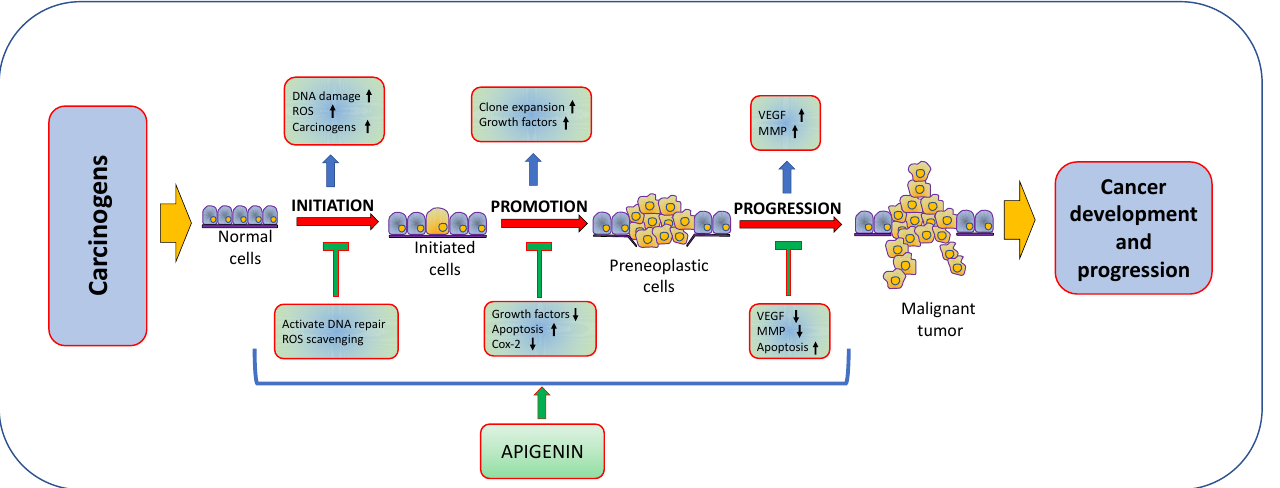
Figure 3. Anti-cancer activity of apigenin: Apigenin plays a significant role in cancer inhibition through inhibiting the carcinogenesis by many various molecular interactions and processes, such as the regulation of the apoptotic machinery, aberrant cell signaling and oncogenic protein network.